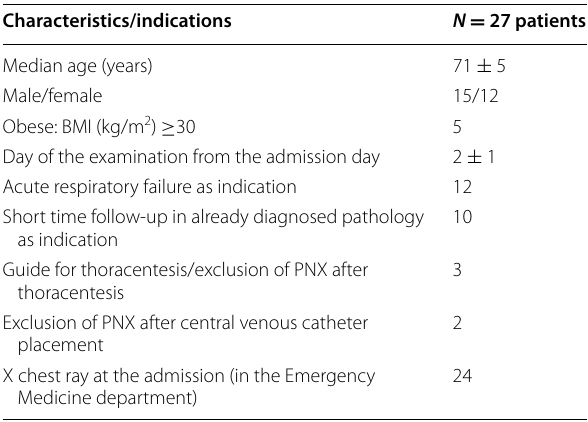
Table 1 Baseline characteristics of the examined patients and indications requested by physicians to perform